Question: Reading the figure, is the described quantity rising or falling?
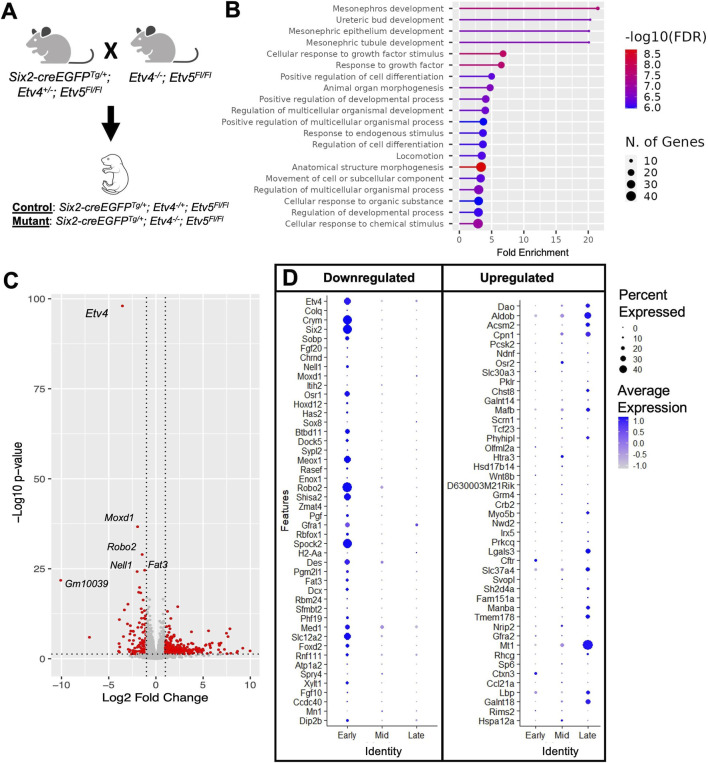
Answer: increasing